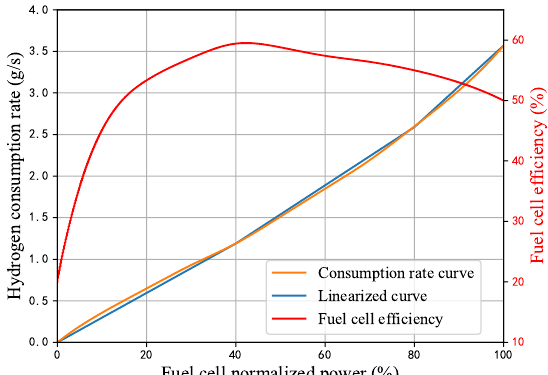
Figure 5. Typical profiles of instant efficiency and hydrogen consumption rate for a fuel cell stack. The fuel cell power normalized power is the ratio of the instant power output of the fuel cell in each distance segment to the maximum fuel-cell power. The curves are linearly scaled based on model used in [39]. It can be seen that fuel cells are more efficient with intermediate power output, i.e., 40% to 60% of the maximum